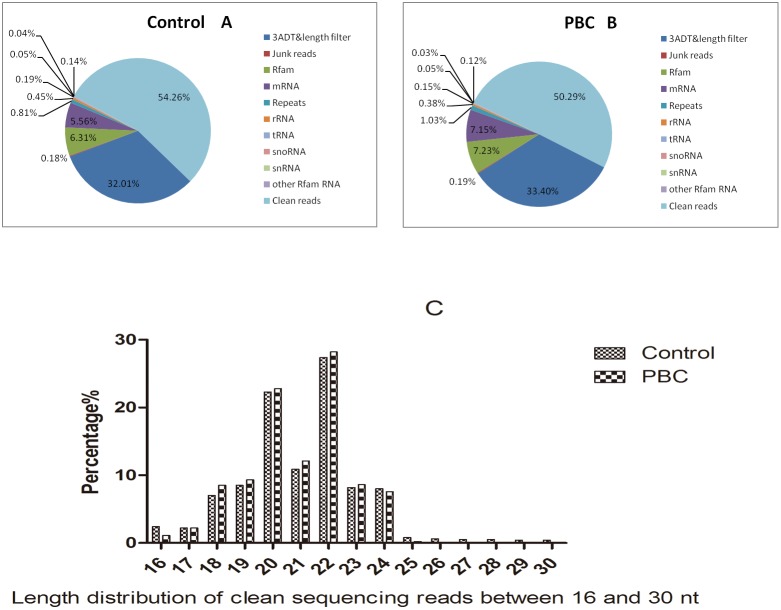
Sequenced reads and distribution of reads.The Illumina Hiseq 2000 sequencing of the small RNA library from the serum of healthy controls and PBC patients produced 8,580,434 and 9,371,001 raw-reads, respectively. After extensive preprocessing and quality control, these raw reads were reduced to 659,447 and 482,263 clean reads, indicating 54.26% and 50.29% of sequenced reads, respectively (Fig. 2A, 2B). The distribution of all reads from 16 to 30 nt is presented in Fig. 2C.